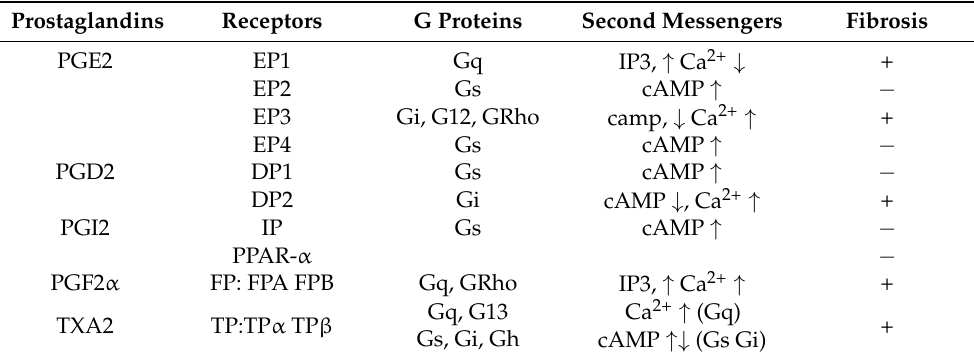
Table 1. PG receptor associated signal transduction and effect on fibrosis. Prostaglandins